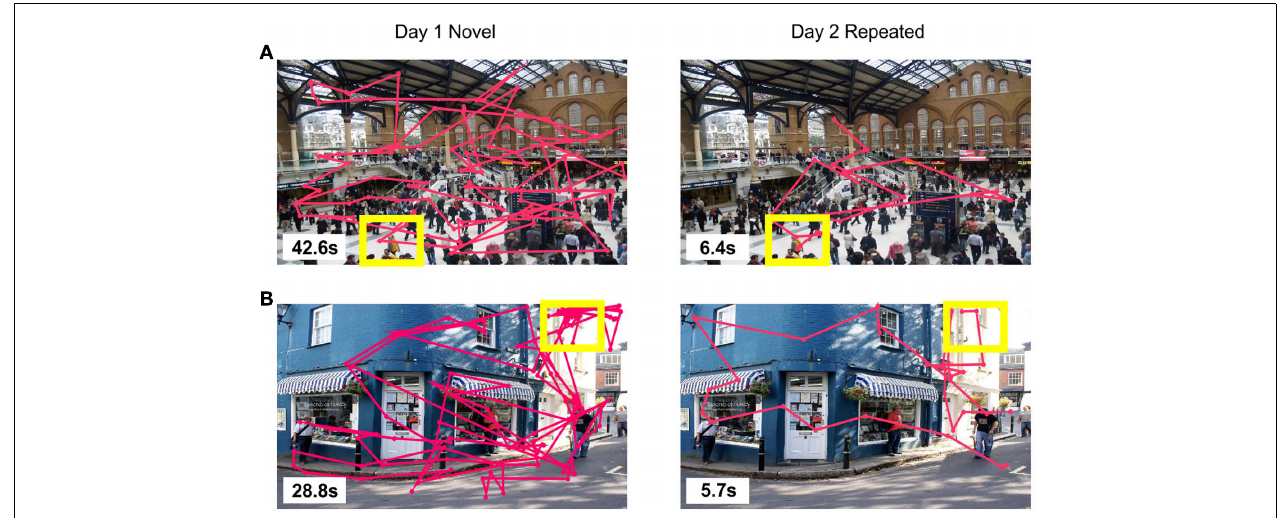
threshold. Search times are shown in the lower left corner of each image, with consecutive fixations connected by a pink line; target objects are indicated by yellow boxes, none of which were displayed during a